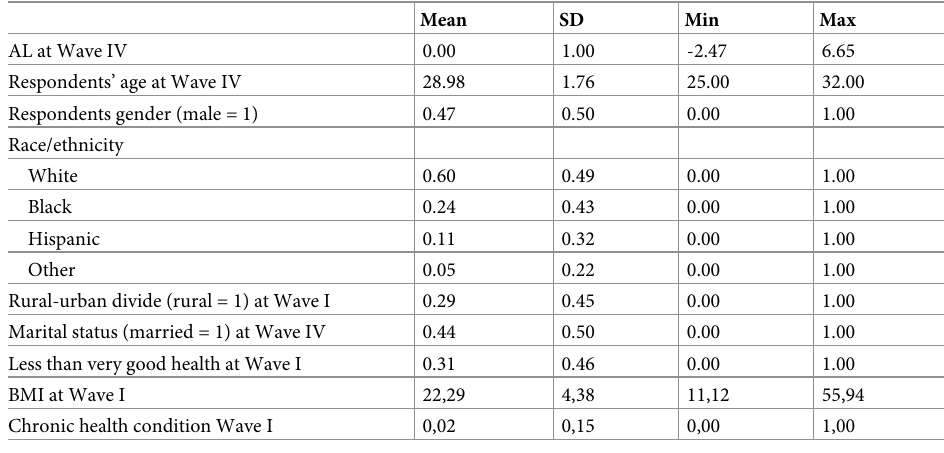
Table 1. Descriptive statistics.